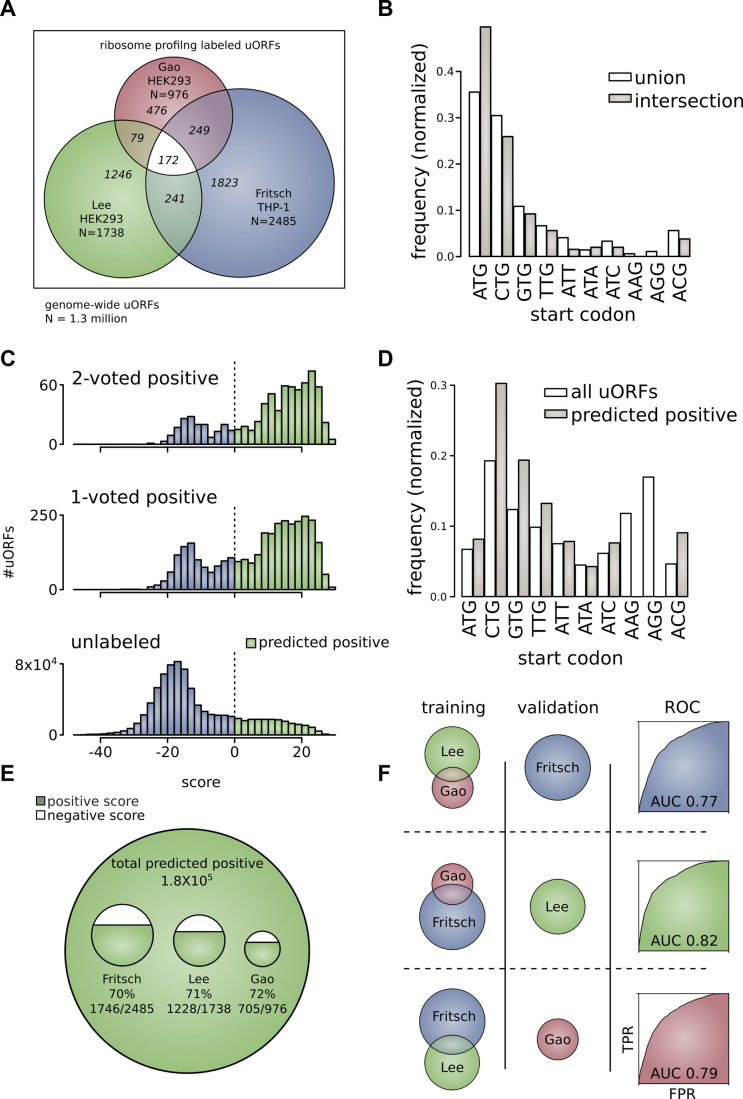
(A) Ribosome profiling identified uORFs as a subset of all uORFs. The universe of all uORFs is identified through comprehensive search of the GENCODE human genome annotation [outer border]. Ribosome profiling studies of Fritsch et al., Lee et al., and Gao et al. are shown as overlapping subsets of this universe. Pair-wise and three-way intersections between these experiments are highlighted. (B) Frequency of translated uORF ATG start codons and near-cognate start codons from ribosome profiling experiments. Frequency for uORFs translated in any experiment (union) or in more than one experiment (intersection). (C) Score distributions for upstream open reading frames. Score distributions for 2-voted positive uORFs that are translated in two or more ribosome profiling experiments (top), 1-voted positive uORFs that are translated in only one ribosome profiling experiment (middle), and unlabeled uORFs uncovered through genome-wide search (bottom). (D) The frequency of uORF ATG start codons and near-cognate start codons of predicted positive upstream open reading frames. Frequency is given for all uORFs genome-wide and for the subset of uORFs that are predicted to be active (predicted positive). (E) uORFs predicted as positive from genome-wide scan and ribosome profiling experiments. Approximately 180,000 uORFs in the genome are predicted as active upstream open reading frames. This large set includes substantial proportions of uORFs identified in the ribosome profiling experiments (∼70% each). (F) Performance of the machine learning algorithm. The machine learning algorithm was trained on two of three ribosome profiling data sets and used to extract the third data set from among unlabeled examples. The ROC curve is shown for each of the three combinations: (i) train Lee et al. and Gao et al.—extract Fritsch et al. (AUC = 0.77), (ii) train Fritsch et al. and Gao et al.—extract Lee et al. (AUC = 0.82), (iii) train Lee et al. and Fritsch et al.—extract Gao et al. (AUC = 0.79),